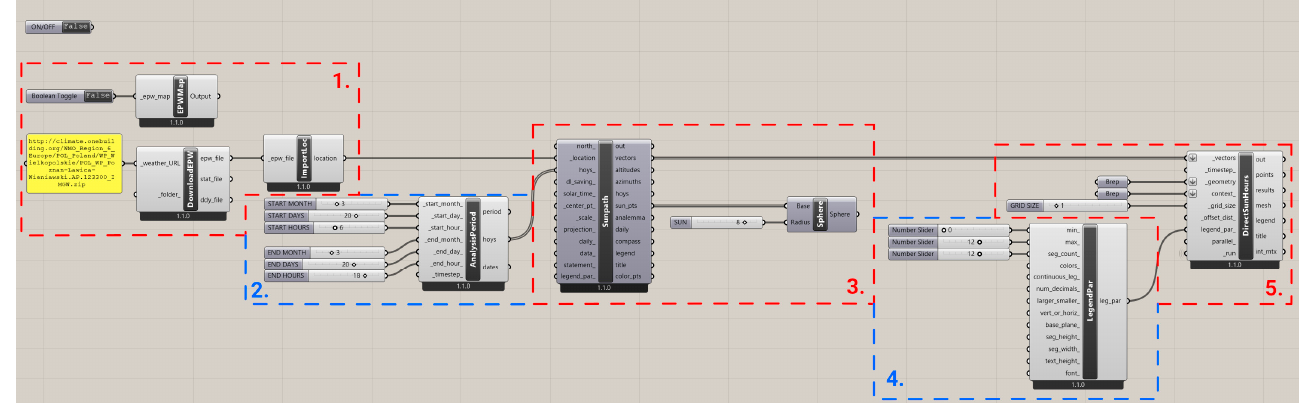
Figure 8. A calculation script in Grashopper 1.0.0007 (1. Importing location and weather data; 2. Defining the time span of analysis; 3. Generating the line of the sun for the given location and time; 4. Defining the scope of the legend; 5. Importing the solid model of the analysed building block).